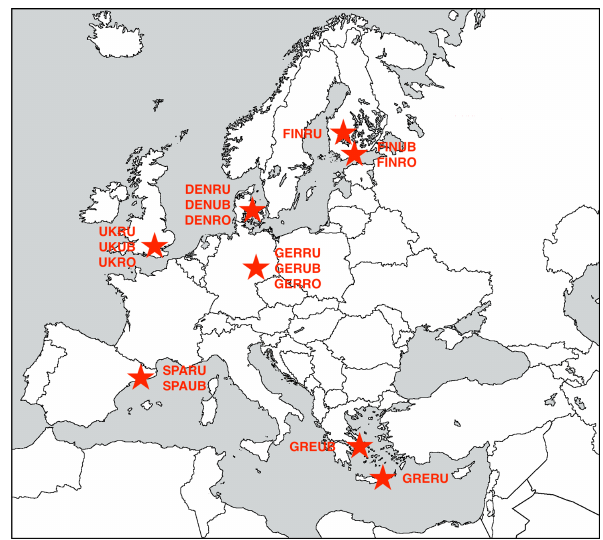
Figure 1. Map of the sites in the present